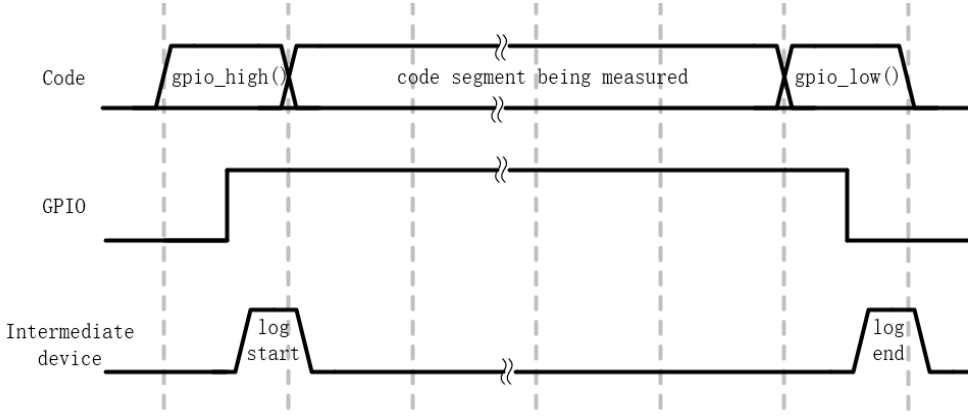
Figure 1. Time sequence demonstrating how the intermediate device logs timestamps via GPIO.